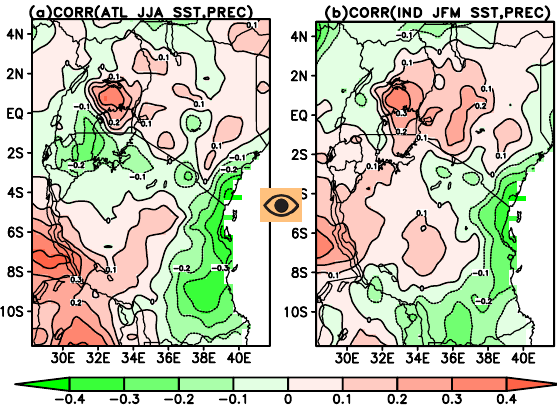
Figure 8. Lead correlation between precipitation and SST averaged over (a) Atlantic Ocean (b) Indian